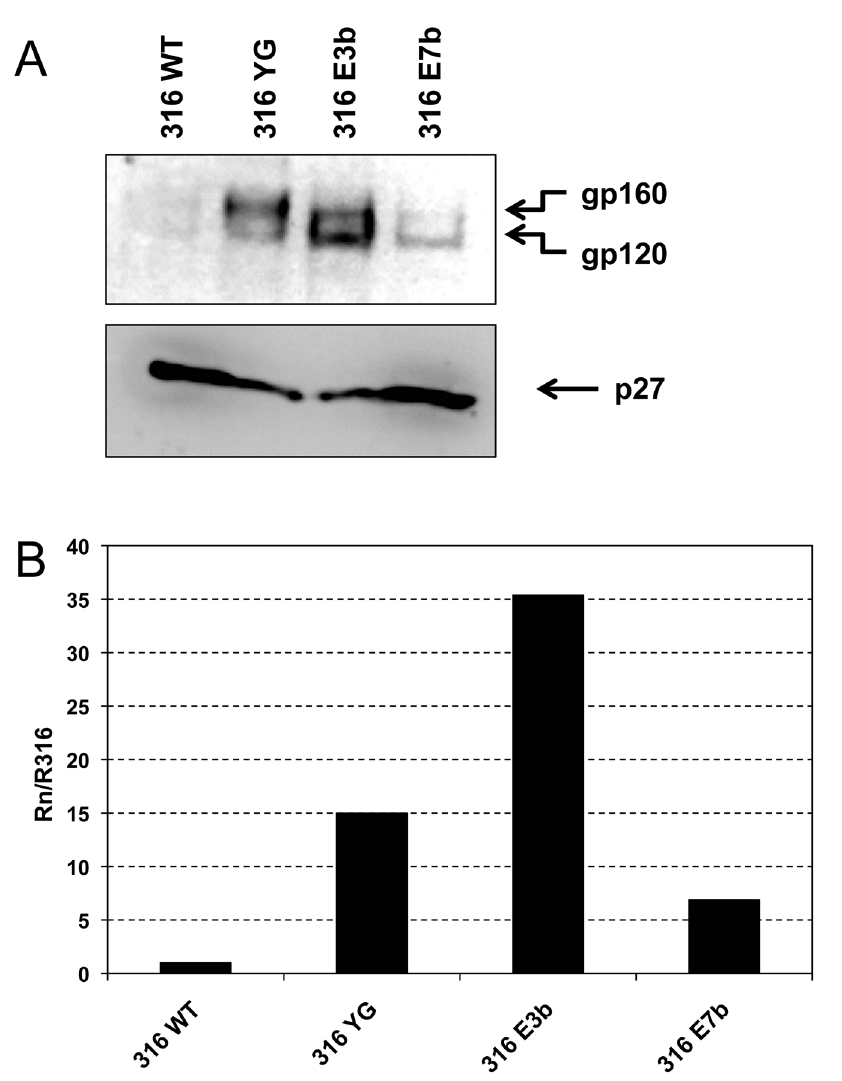
Figure 7. Virion incorporation of SIVmac316 Env is highly responsive to mutations of potential trafficking motifs. Viruses were produced by transfection of HEK293T cells and virions were pelleted from the clarified supernatants. ( A ) gp160/gp120 (top panel) and p27 (bottom panel) were detected by Western blot using antibody 3.11H and 2F12, respectively. ( B ) Relative Env incorporation into virions. The ratios of gp120 to p27 were calculated by phosphorimaging analysis. Data are presented as the gp120:p27 ratio of mutant virions (Rn) relative to the gp120:p27 ratio of SIVmac316 wild-type (WT) virions (R316). Data shown are representative of three independent